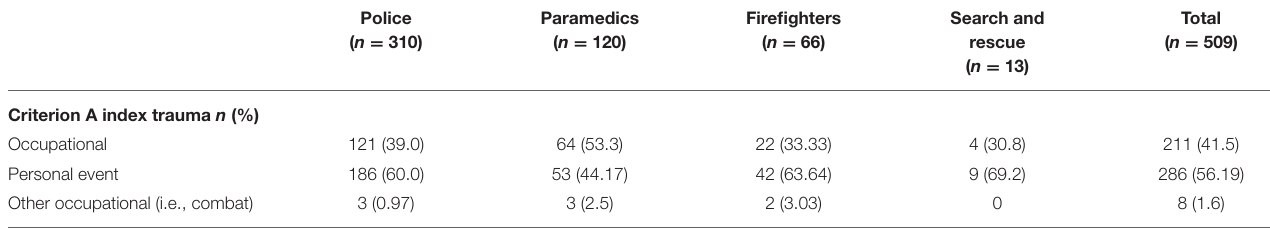
TABLE 3 | Criterion A index trauma by service.